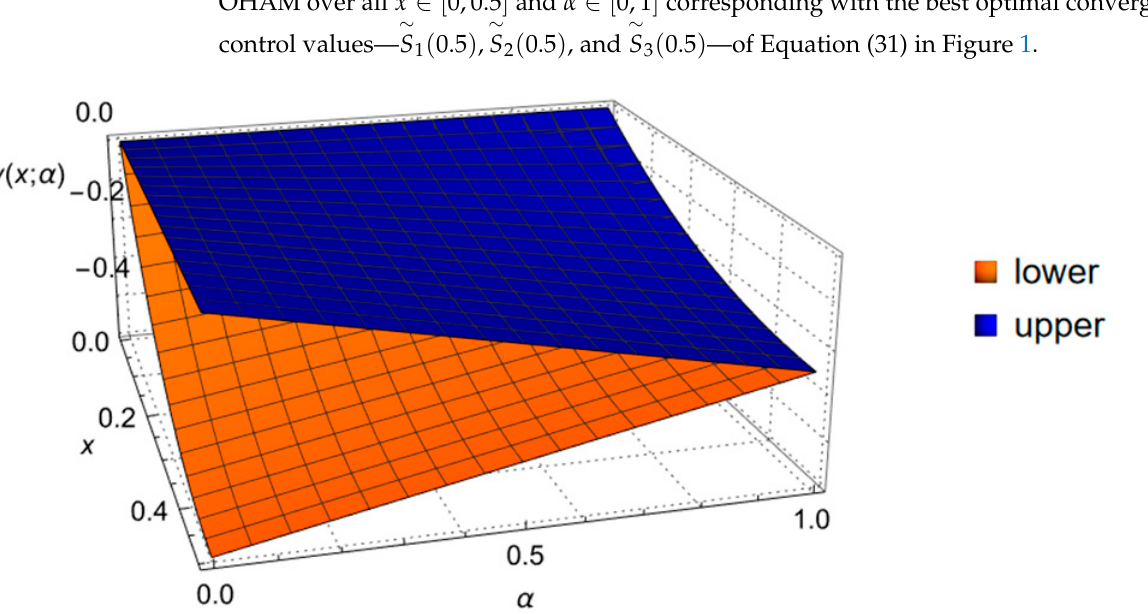
Using a three-dimensional graph, we summarize the solutions using the third-order FF- OHAM over all x ∈ [ 0, 0.5 ] and α ∈ [ 0, 1 ] corresponding with the best optimal convergence